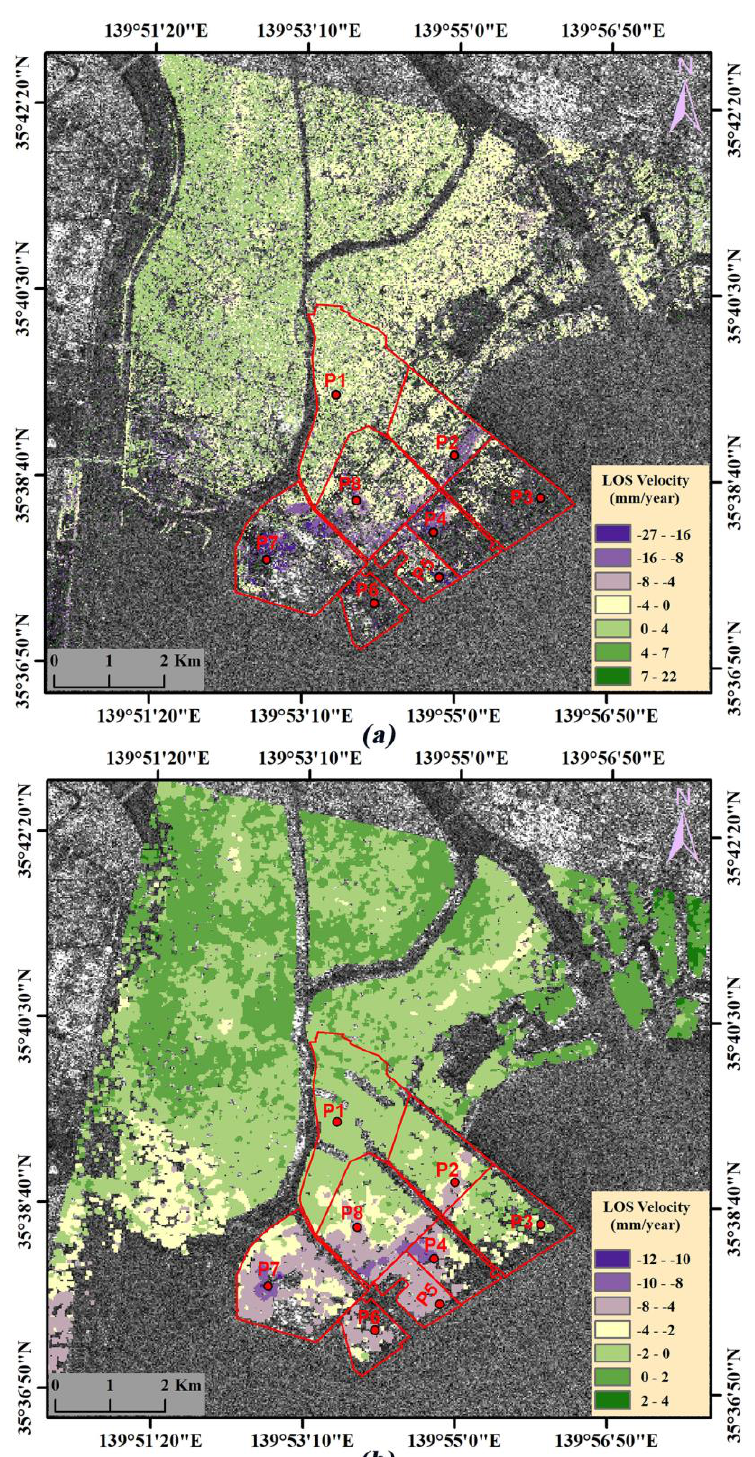
Figure 3. Line of sight (LOS) displacement velocity in Urayasu City from 1993 to 2006 for the ERS-1/-2 data: ( a ) Estimated mean displacement velocity using the PSI method; ( b ) estimated mean displacement velocity using the SBAS method. The background image is an ERS-2 intensity image acquired on May 24, 1999. The red points P1 to P8 are the selected points to show the time-series LOS displacements estimated by the PSI and SBAS measurements in ( a ) and ( b ), respectively.